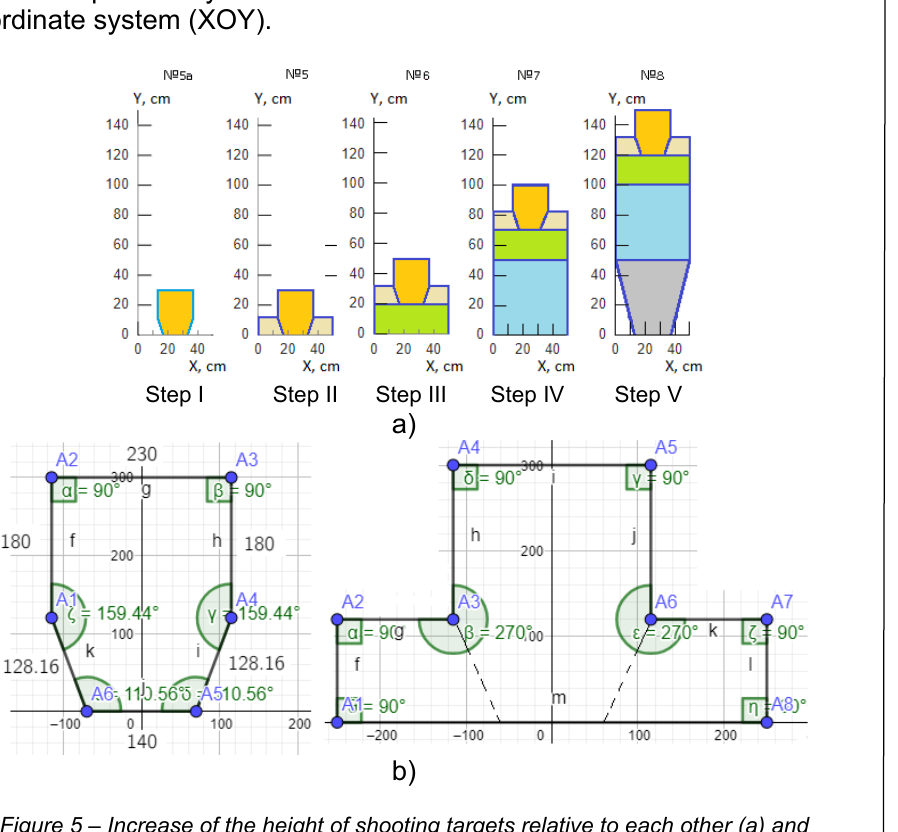
Figure 5 – Increase of the height of shooting targets relative to each other (a) and their structure